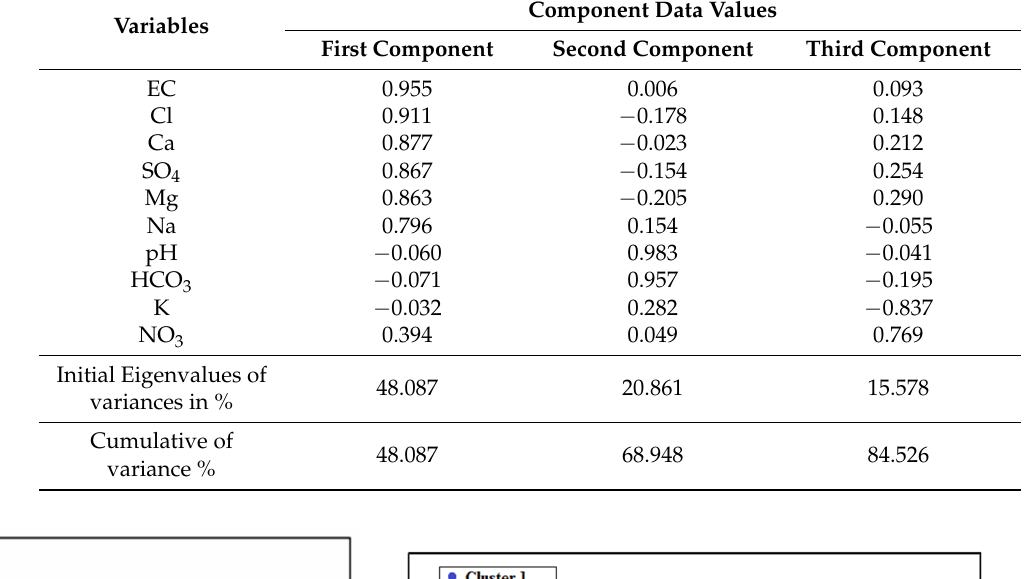
Table 2. The score of PCA after Varimax rotation.